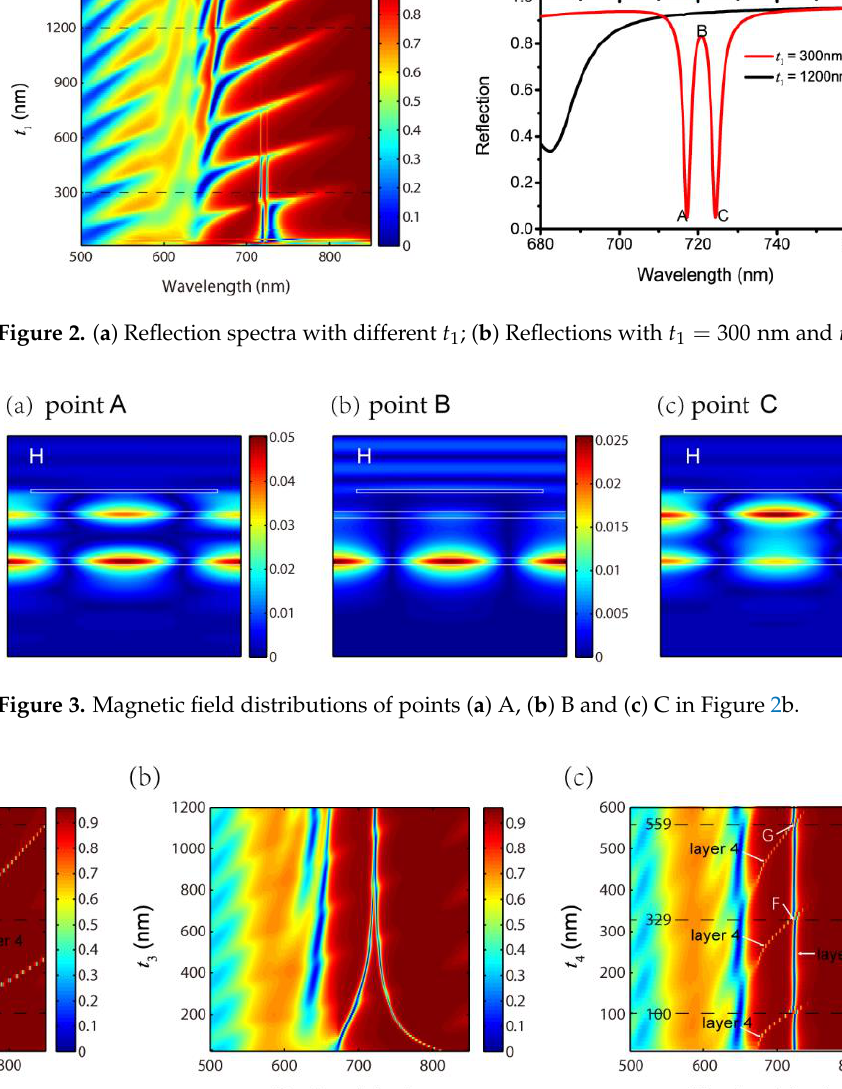
t . Figure 4. Reflection spectra with different ( a ) t 4